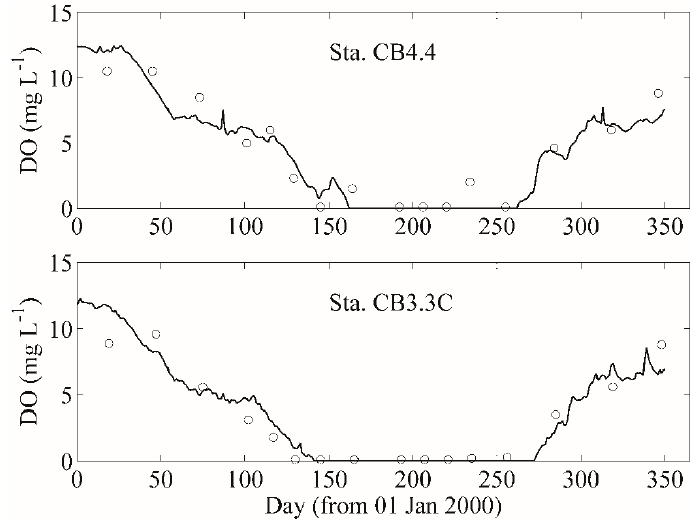
Figure 17. Comparisons of the simple Shen et al. [21] model (solid lines) and DO observations at two stations in the Chesapeake Bay. (Reuse and minor adaptation from Shen et al. [21], with permission from Wiley. © 2013, by the Association for the Sciences of Limnology and Oceanography, Inc.).